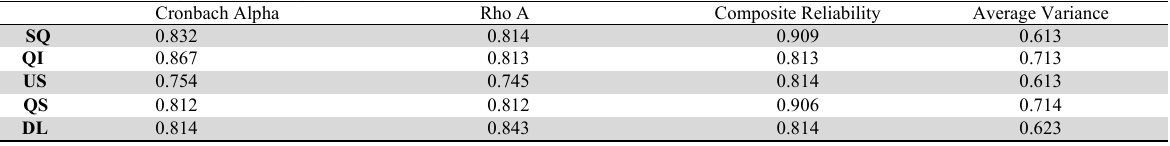
Construct Reliability and Validity